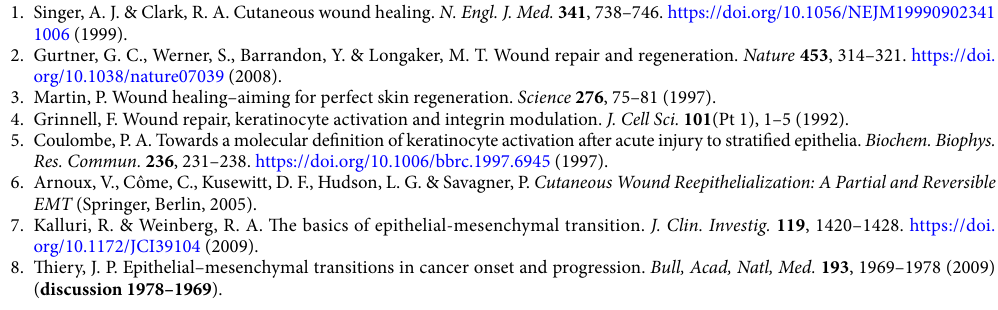
Figure 7. In vitro experiment using HaCaT cells to compare among normal culture condition, TGFβ1 solo-stimulation, FGF2 solo-stimulation, and TGFβ1 and FGF2 co-stimulation (TGFβ1 + FGF2). ( a ) HaCaT cells gradually showed not only the disseminated pattern but also spindle morphology with TGFβ1 and TGFβ1 + FGF2 treatment in the time course of cell culture from 24 to 72 h. Higher magnification images are at the corners. Scale bar: 20 μm ( b ) Realtime RT-PCR analysis of HaCaT cells. The Y-axis represents the relative ratio compared with CTL. mRNA expression of E-cadherin, vimentin and Snai2 was highly and significantly upregulated in TGFβ1. Vimentin and Snai2 were further upregulated by TGFβ1 + FGF2 co-treatment than TGFβ1 solo treatment especially at the time point of 72 h. ( c ) mRNA expression of Snai1 increased with TGFβ1 but suppressed with FGF2 and TGFβ1 + FGF2 at 72 h. Twist1 was increased with TGFβ1 at 48 and 72 h, and TGFβ1 + FGF2 at 48 h. β-catenin was similarly upregulated by TGFβ1 and TGFβ1 + FGF2 treatment at both time points. Notch1 was significantly suppressed by TGFβ1 and TGFβ1 + FGF2 treatment. Solo treatment with FGF2 affected little in expressions of EMT-related transcription factors in HaCaT cells. ( d ) Transcription of FGFR1 in HaCaT cells showed a significant increase with TGFβ1 in comparison with control and FGF2 treatment at 48 h. Bar graphs are presented with the mean values ± standard error. * p < 0.05, ** p < 0.01, ANOVA with a post hoc Tukey